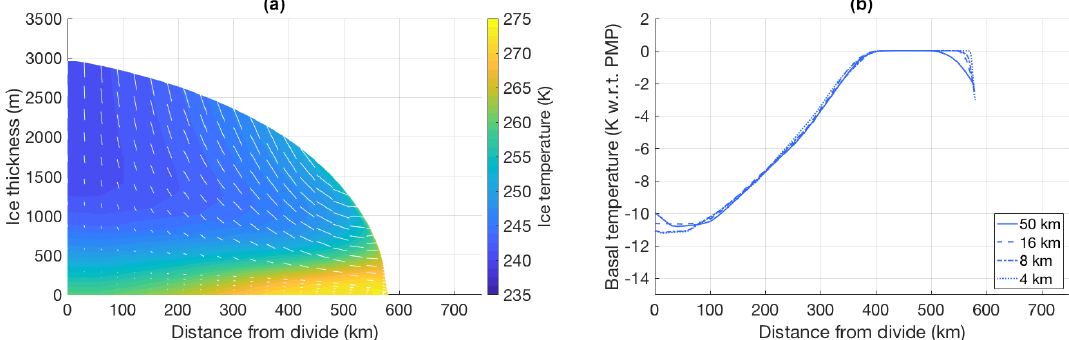
Figure 6. (a) Ice temperature and velocity vectors for the steady-state ice sheet in experiment I, as produced by UFEMISM with a 4km ice-margin resolution. (b) Basal temperature transects for the different simulations in the same experiment.